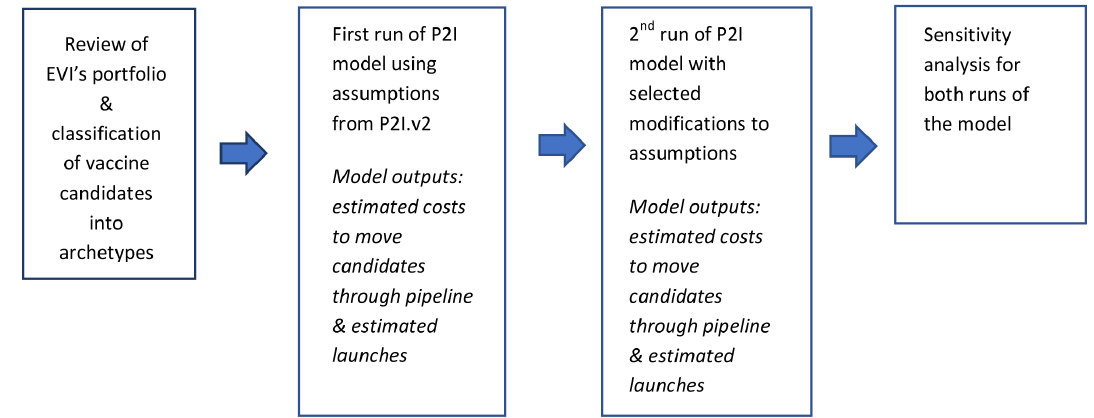
Figure 1. Four key phases in the